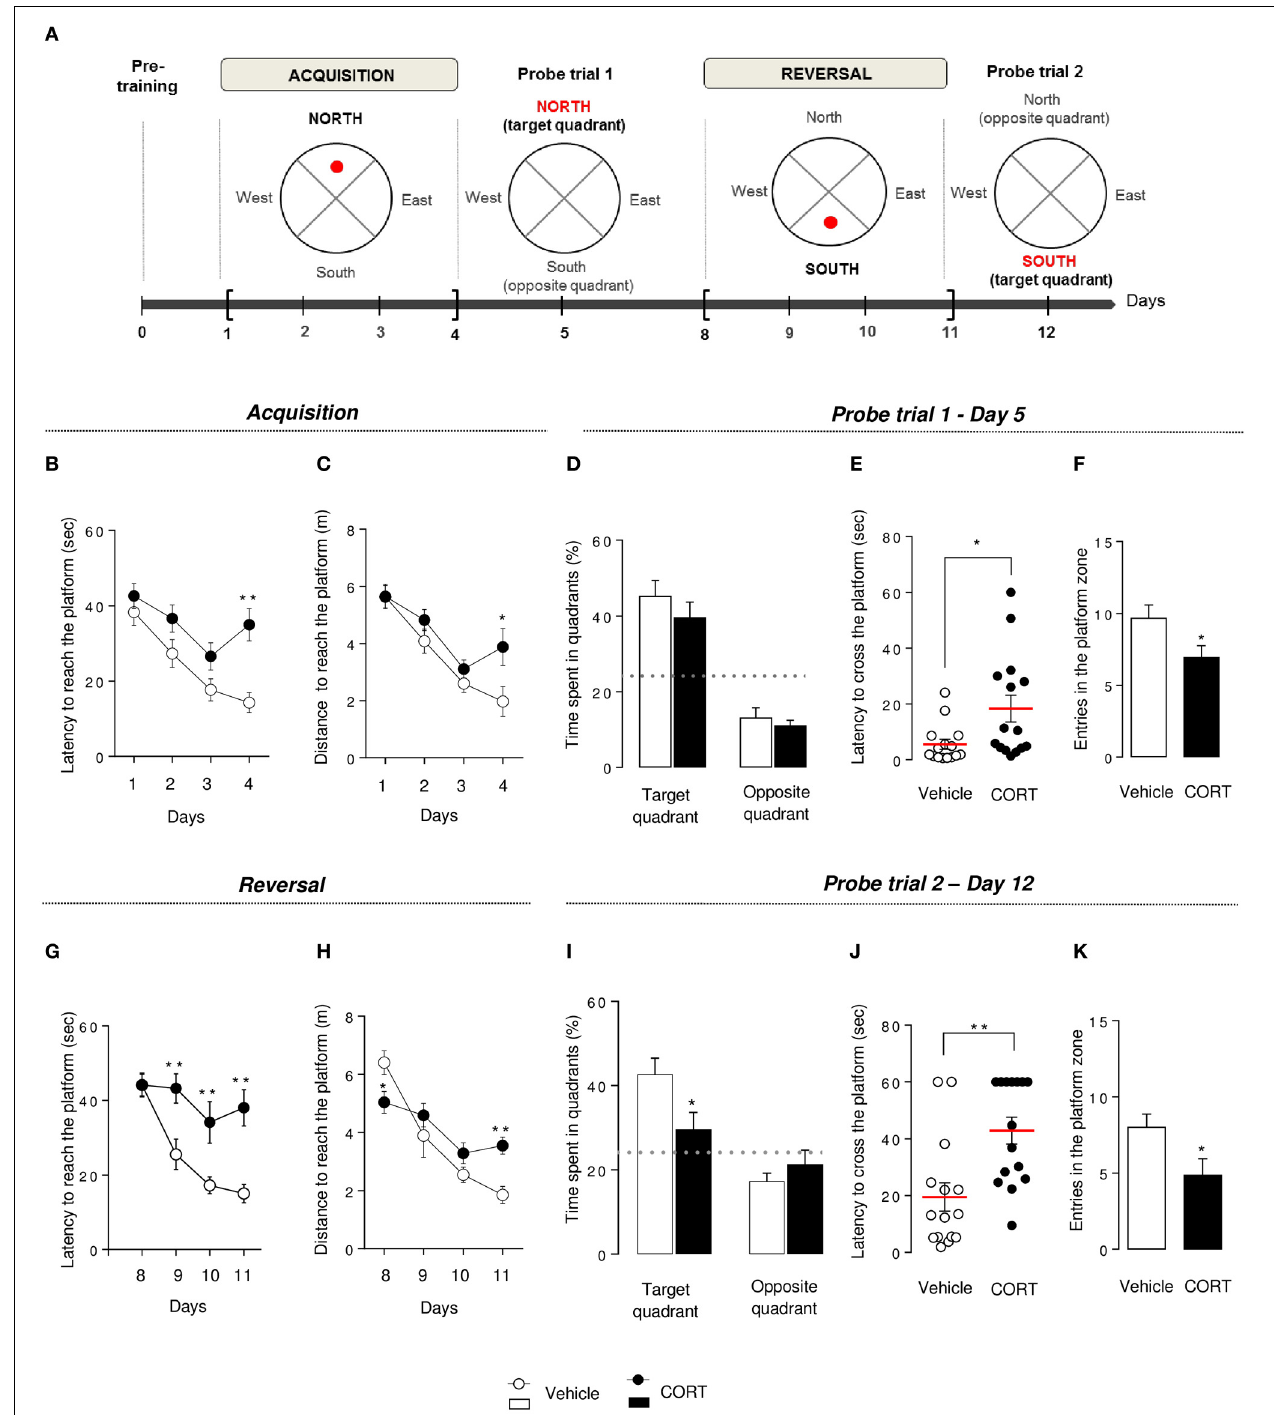
FIGURE 4 | Chronic corticosterone affects spatial learning performances, short-term memory and cognitive flexibility in the Morris water maze. Schematic diagram of the MWM experimental time course (A) . After a pre-training phase (day 0), the MWM protocol was divided into 2 phases. Each phase includes a 4-day learning period followed by a probe session without the platform. During acquisition, mice learned to locate the platform in the target quadrant (North) then have to locate the platform in the opposite